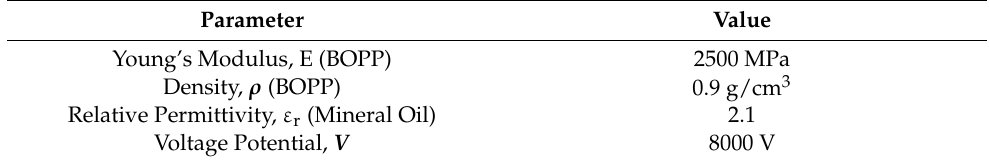
Table 2. Material